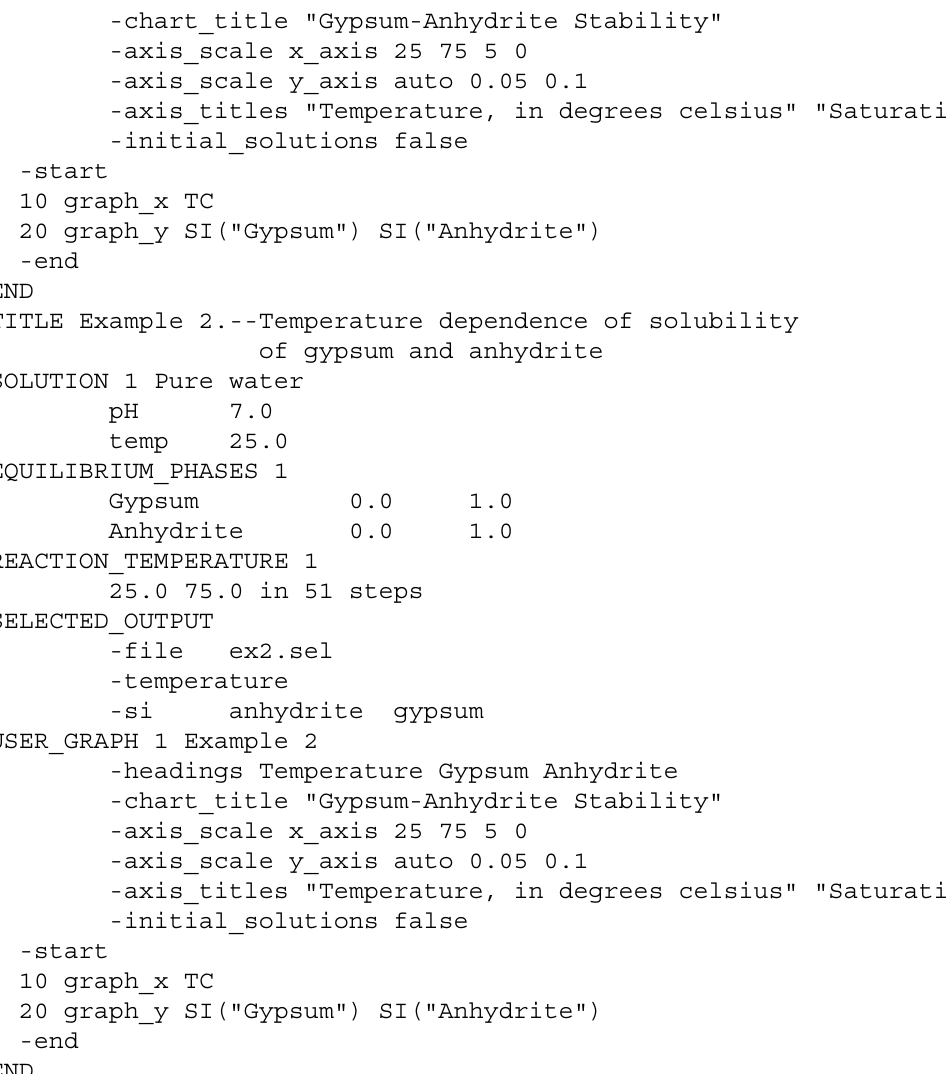
Table 12. Input file for example